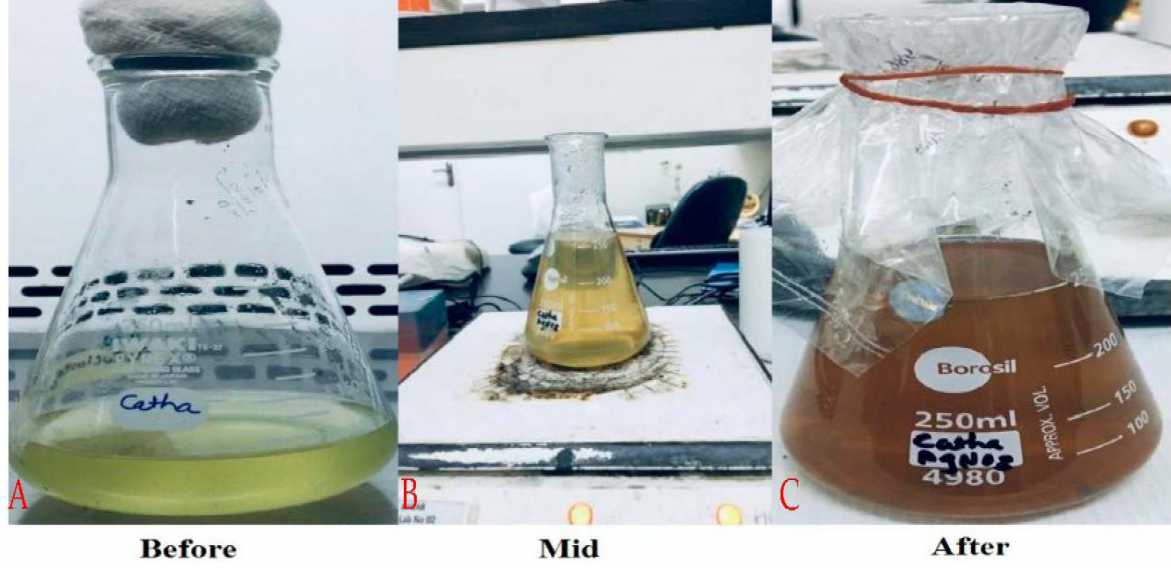
Figure 1. Synthesis of C. roseus silver nanoparticles (AgNPs). ( A ) C. roseus extract. ( B ) Synthesizing silver-nanoparticles. ( C ) Synthesized silver